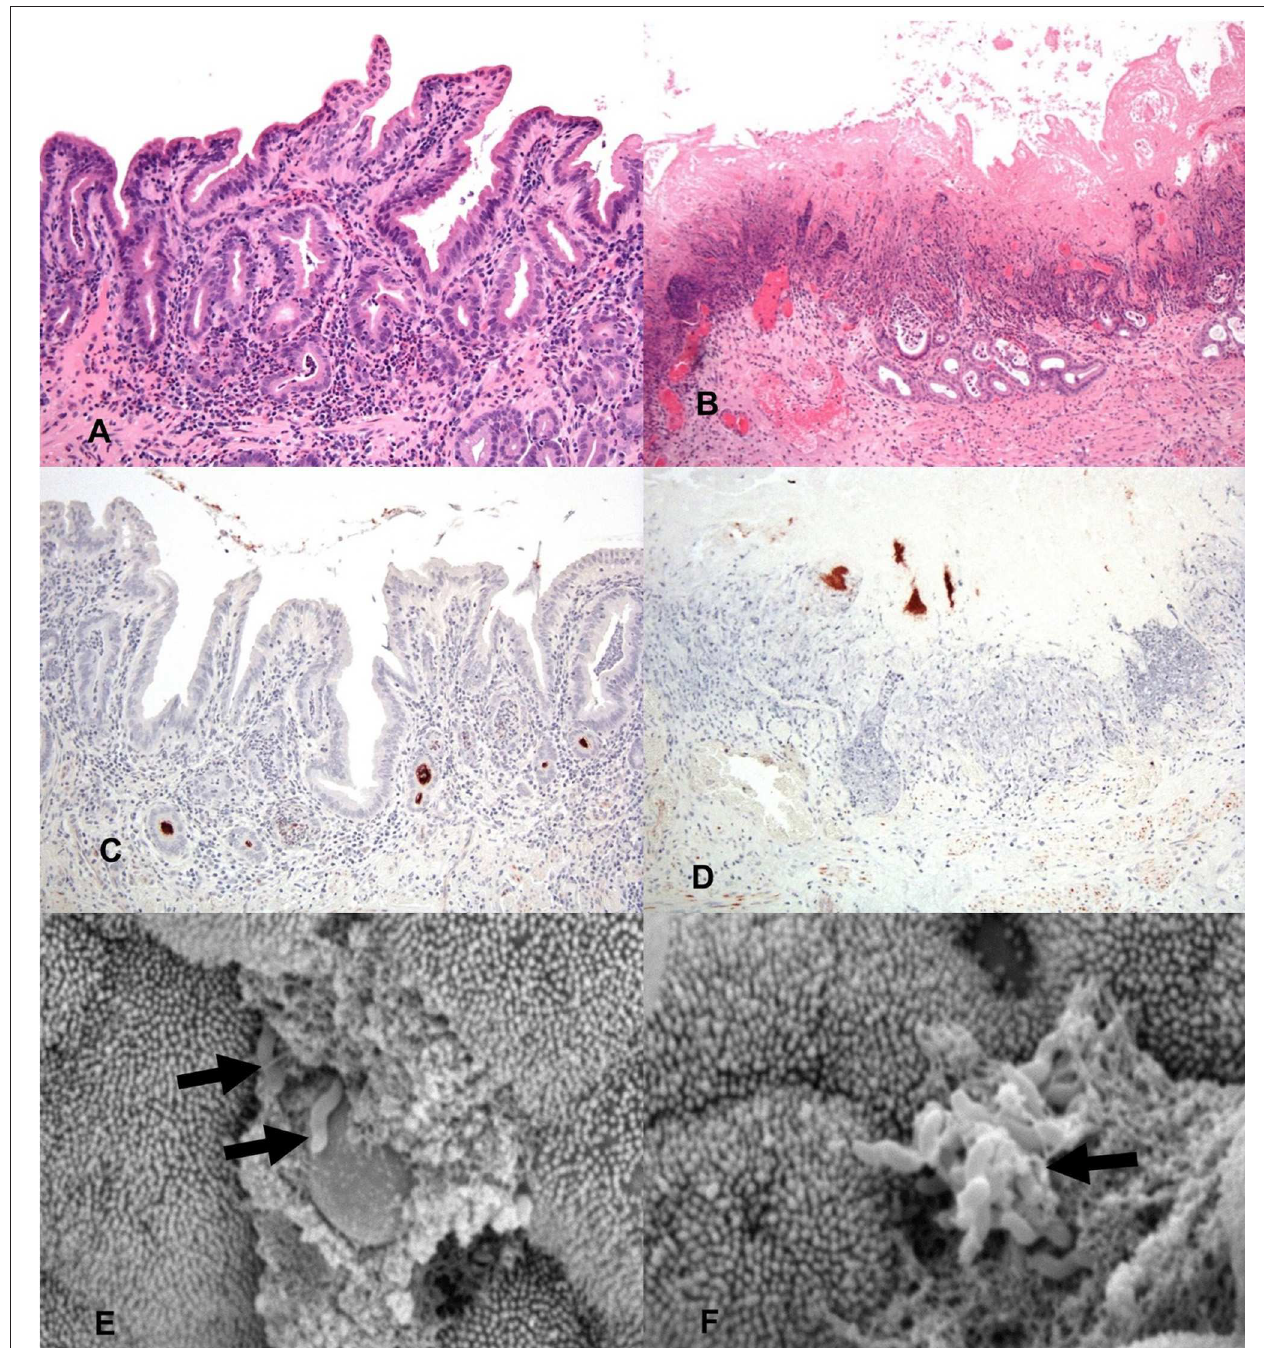
FIGURE 2 | General histology (HE) of inoculated gallbladders and localization of C. jejuni within the gallbladder via IHC and SEM. (A) 2h post-inoculation there are mild to moderate diffuse inflammatory infiltrates in the lamina propria mildly separating and surrounding mucosal invaginations. There is distension of the basal aspect of multifocal mucosal invaginations by inflammatory cells and cellular debris. Hematoxylin and eosin (HE). (B) 24h post-inoculation the mucosal architecture is diffusely disrupted, the apical mucosa is necrotic, moderate numbers of glands are lined by attenuated epithelium, are ectatic and partially filled with mucus, degenerate neutrophils and pkynotic cellular debris. Hematoxylin and eosin (HE). (C) IHC staining for C. jejuni (brown) shows aggregates of organism deep within mucosal invaginations, on the mucosal surface, and in luminal debris 2h post-inoculation. (D) IHC staining for C. jejuni (brown) shows organisms present in the necrotic remnants of mucosal invaginations 24h post-inoculation. (E) A focal ulceration, with two intralesional C. jejuni organisms (arrows). Scanning electron micrograph (SEM). (F) Scanning electron micrograph (SEM) of the gallbladder mucosal surface with an aggregate of C. jejuni organisms (arrow) adherent to the apical aspect of the mucosa with associated microvillus loss, clumping and blunting of adjacent microvilli.